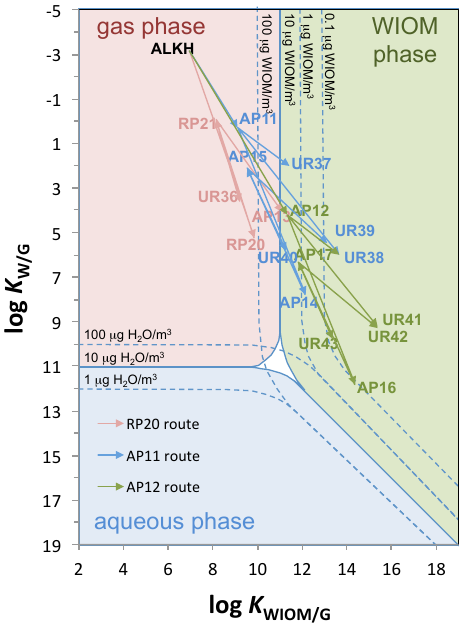
Figure 7. Oxidation products of the n -alkane with 17 carbon atoms placed within the chemical partitioning space based on partition co- efficients at 25 ◦ C predicted with ppLFERs and connected by ar- rows based on sequence of reaction by which they are formed. The code names for the compounds are based on Jordan et al.